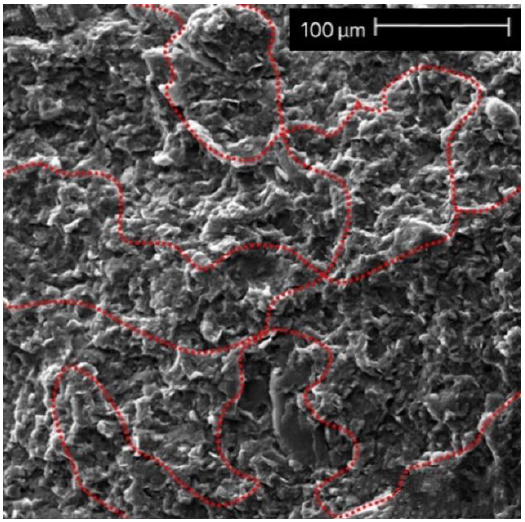
Figure 5. SEM image of the thermal path formed by the connection of thermally conductive fillers (Mag = 500 × ). Adapted with permission [30], Copyright 2018, Advanced Composites and Hybrid Materials.